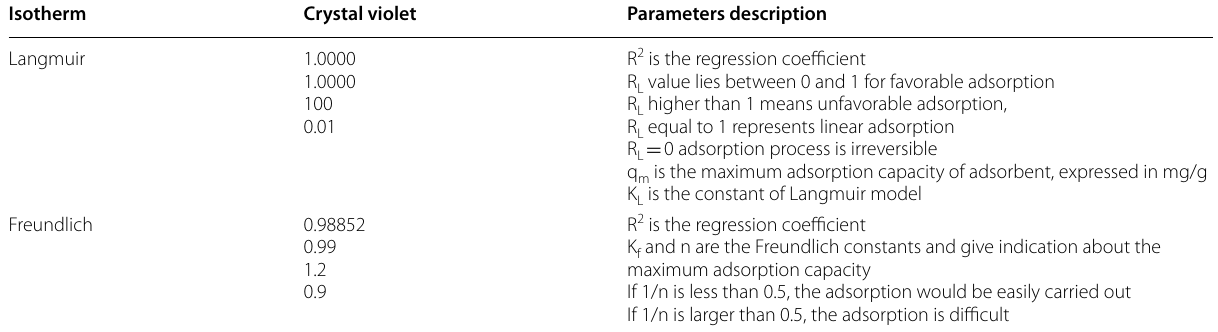
Table 2 Freundlich and Langmuir isotherms parameters for crystal violet adsorption on sodium titanates at room temperature Isotherm Crystal